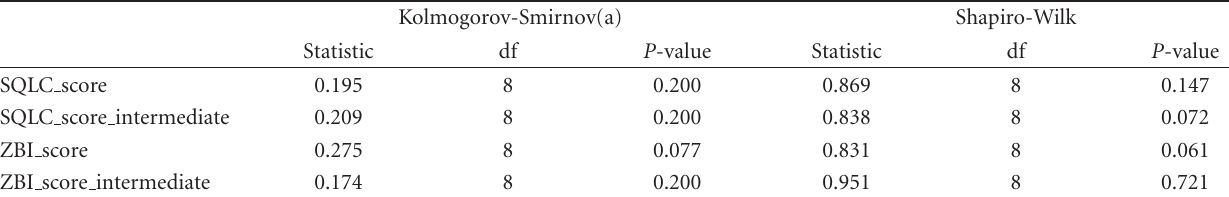
Figure 4: Boxplots of ZBI scores (baseline N = 28, intermediate N = 12) according to city. Table 5: Tests of